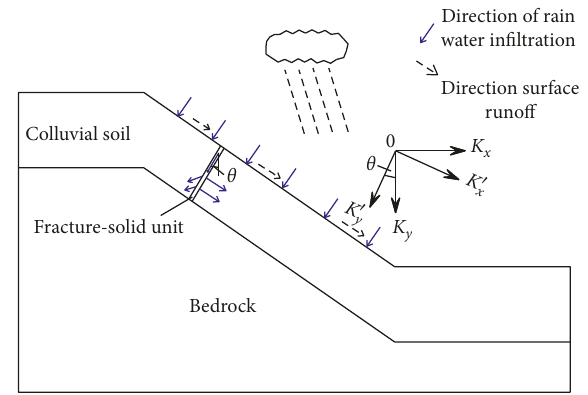
Figure 1: Fracture permeability coefficient and global coordinate system